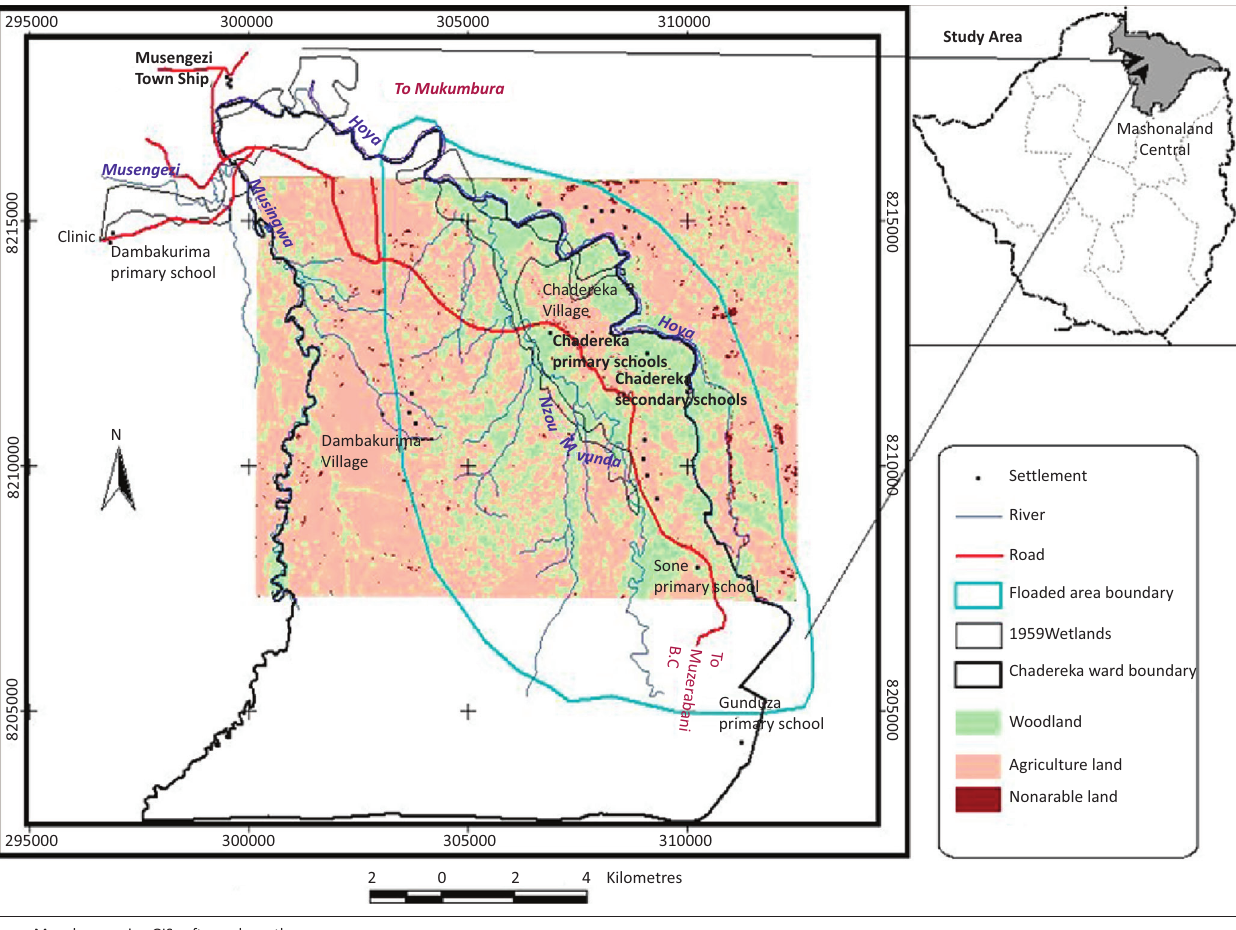
FIGURE 1: The location of Chadereka